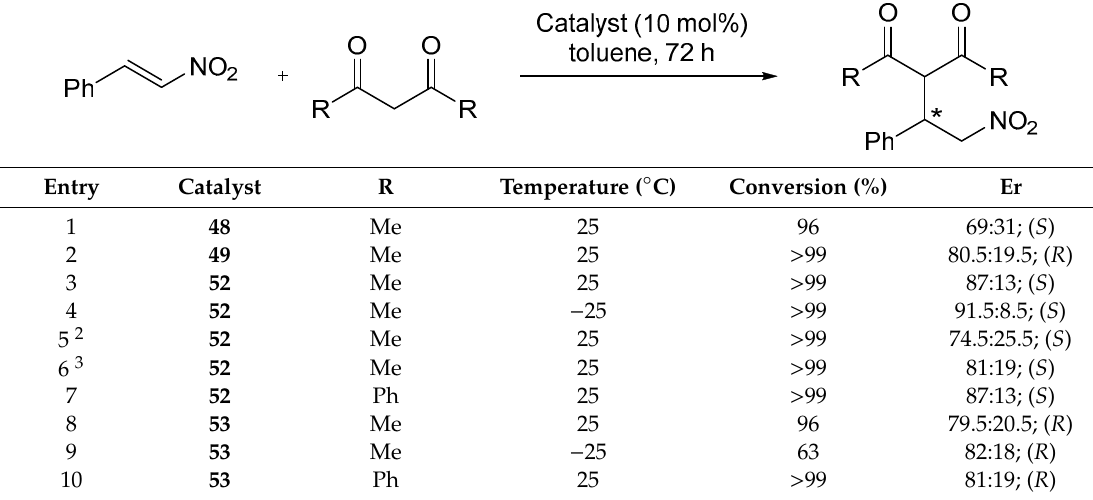
Table 2. Catalytic activity of selected camphor-diamine derived noncovalent bifunctional thiourea organocatalysts 48 , 49 , 52 , and 53 in 1,4-additions of 1,3-diketones to trans - β -nitrostyrene 1 .